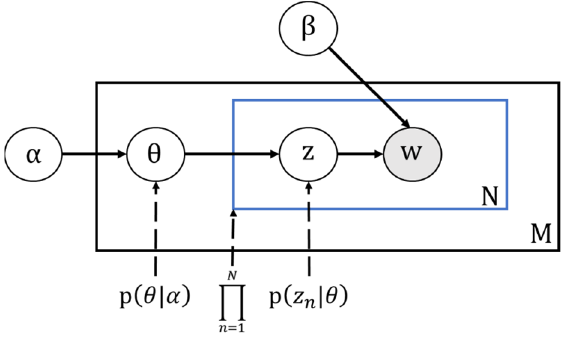
Figure 4. Schematic diagram of LDA